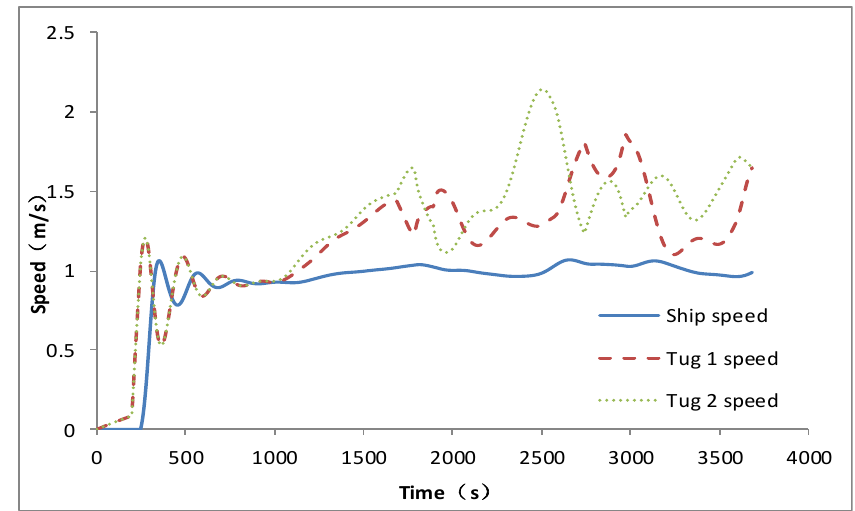
Figure 14. Speed analysis diagram of rotation of towing system under wind action.